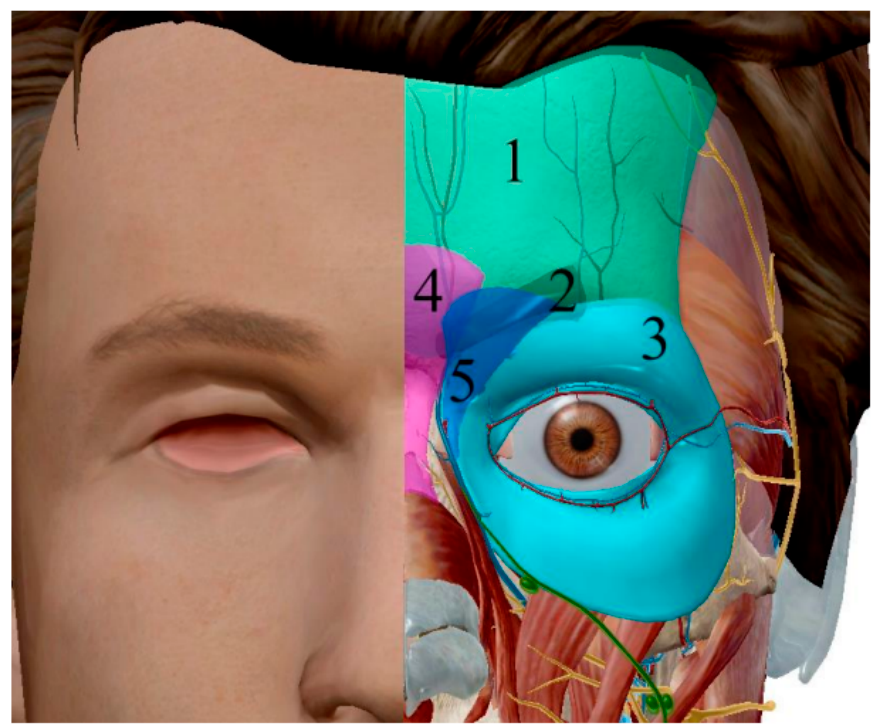
Figure 11. Illustration of (1) frontalis muscles, (2) corrugator supercilia, (3) lateral part of the orbital orbicularis oculi, (4) procerus, and (5) depressor supercilii from a frontal and 45-degree position.